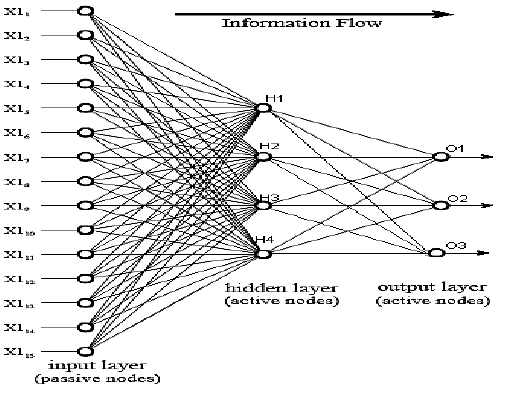
Figure 3: Typical MLPNN